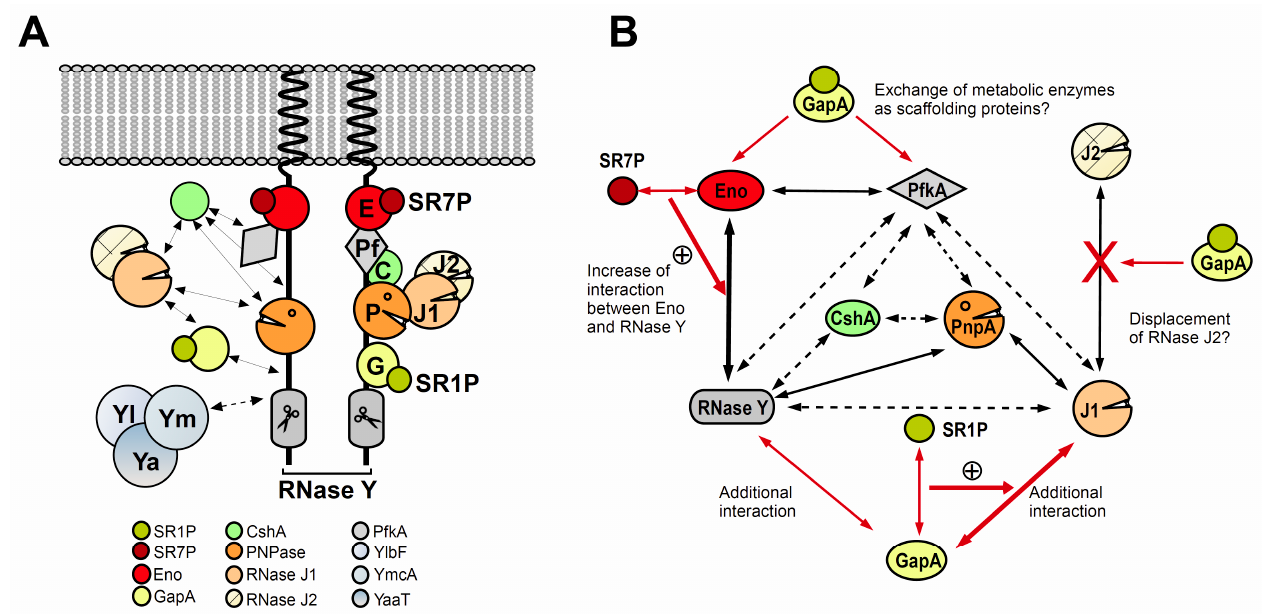
Figure 2. Interactions in the Bacillus subtilis DLN (degradosome-like network). ( A ) Hypothetical organization of the B. subtilis DLN considering all available experimental data [6,9,11,24,28–30]. Shown are the cytoplasm and the cell membrane in which the dimeric main endoribonuclease RNase Y (grey with scissors) is anchored. Its C-terminus provides a scaffold for the interaction with other DLN components: E, Eno; Pf, PfkA; P, PnpA; J1/J2, RNases J1 and J2; G, GapA. Small proteins SR1P and SR7P are depicted as solid circles. CshA (C) and the RNase J1/J2 heterodimer (J1/J2) are mainly located near the ribosomes (left side). However, based on the PnpA–J1 interaction, the latter might be occasionally associated with the DLN (right side). Yl, Ym, Ya symbolize the recently discovered Y-complex, the localization of which is still unclear (dashed arrow) but which is required for the degradation of mRNAs by RNase Y. ( B ) Working model for the role of SR1P and SR7P in the B. subtilis DLN. All interactions obtained using a bacterial two-hybrid system [6] are indicated by black arrows, among them dashed ones that were not corroborated by SPR [29]. Red arrows display interactions obtained by our work [9,11]. Thick red arrows, experimentally substantiated effects; +, increase in interaction and/or enzymatic activity; ?, hypothetical effects.